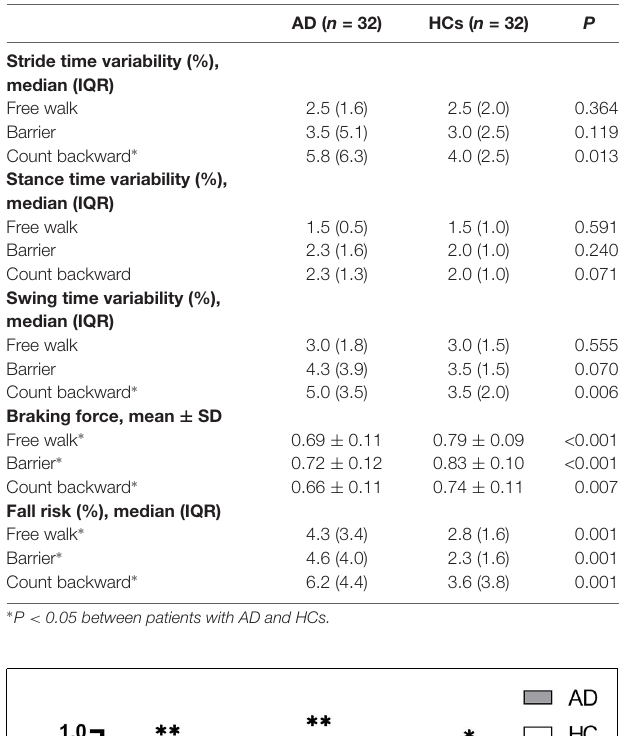
FIGURE 3 | The comparison of stance time variability between patients with AD and HCs in the walking of Free walk, Barrier, and Count backward.